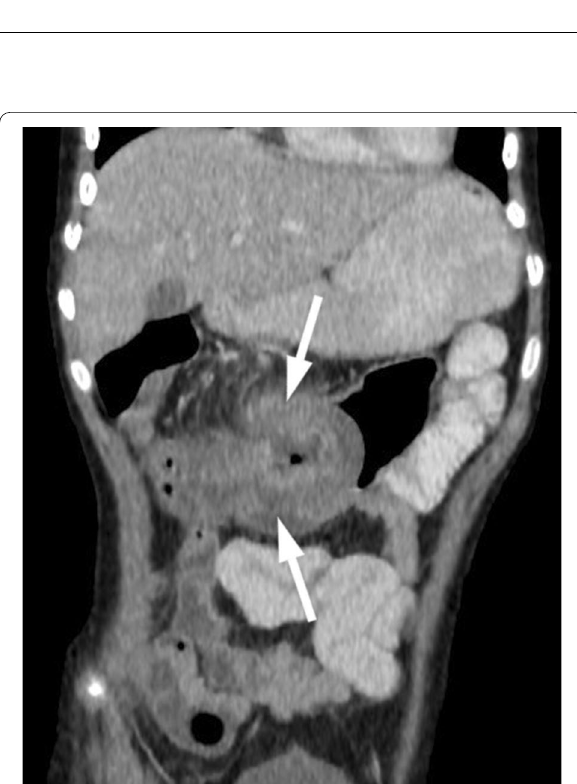
Fig. 1 An 11-year-old girl was admitted with abdominal pain in the last two days. On physical examination, she had abdominal tenderness. On US, there was a suspicious appearance of intussusception. Contrast-enhanced coronal reformatted CT image shows increased wall thickening at the transverse colon seen as intussusception (arrows) and increased mesenteric density. Segmental colon resection was performed, and the histopathological diagnosis was colon